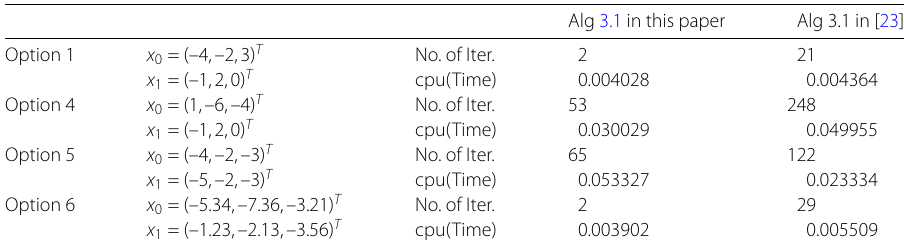
Table 2 Comparison of Algorithm 3.1 in this paper and Algorithm 3.1 in [23]